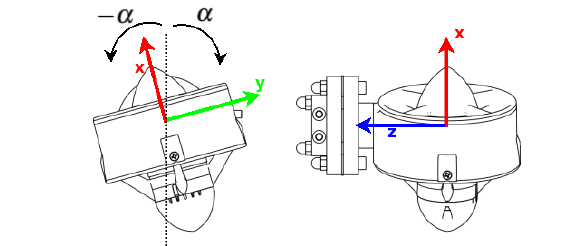
Figure 3. Angle of inclination per each thruster. The value of α is constant for the experiment at 5